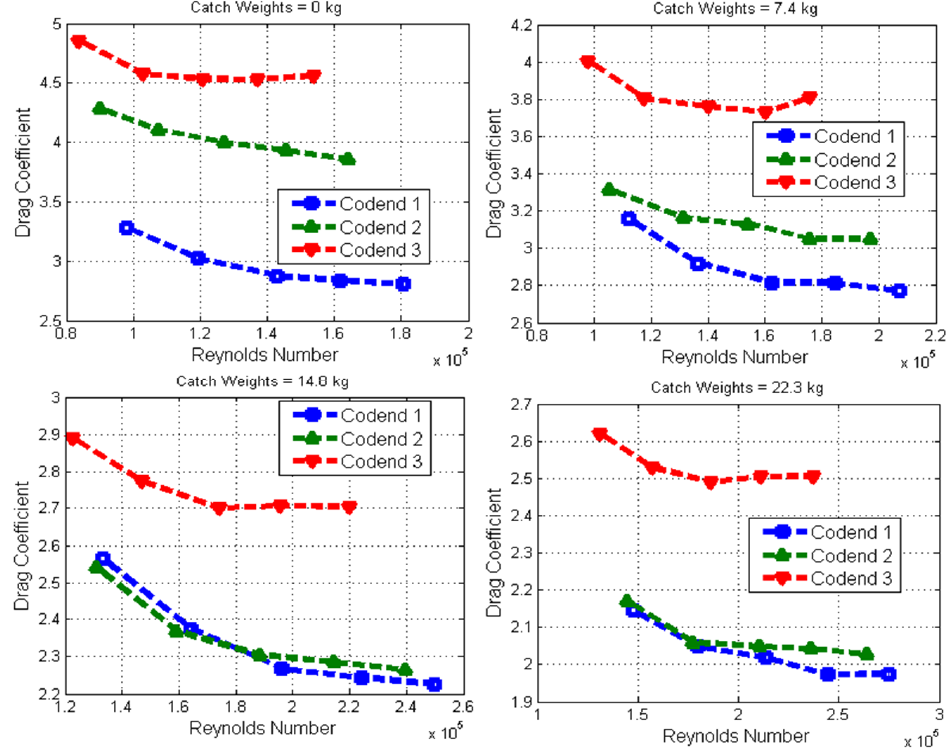
Figure 9. Drag coefficient of the three codends at different catch weight as a function of Reynolds number calculated with codend diameter.